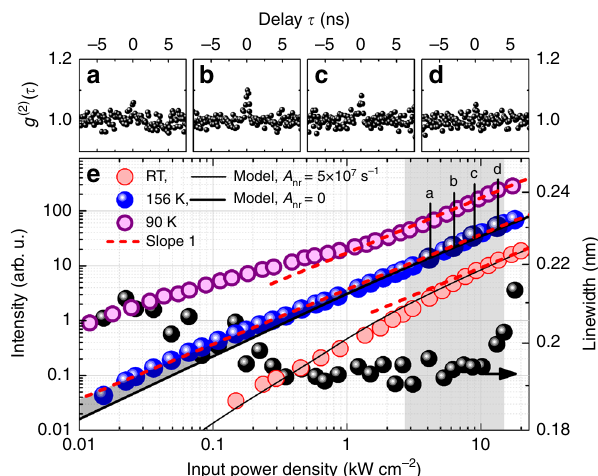
Fig. 3 Optical and quantum-optical characterization of the thresholdless nanobeam emission at a temperature of 156 K. a – d Autocorrelation traces taken at the excitation power densities marked in e display the characteristic bunching around threshold ( b , c ), which vanishes again for higher excitation ( d ), indicating a transition towards Poissonian emission statistics in the lasing regime (shaded excitation range in e ). The bunching in a cannot be fully resolved due to resolution limitation. e Excitation power-dependent I – O curve measured at 156 K (blue) exhibiting a thresholdless behavior and corresponding emission linewidth (black dots). I – O curves measured at room temperature (red) and 90 K (purple) show the development of the I – O characteristics with temperature. Results of our microscopic model, based on a purely 2D QW gain, are shown for RT and 156 K data (solid lines). The I – O curve at 156 K is shown under the assumption of negligible non-radiative losses (nonlinearity solely due to β < 1). The increased output intensity in the low excitation regime, due to contributions from localized states, is apparent at 156 K (shaded). Second- order autocorrelation measurements were performed at 156 K at the data points marked a – d. A slope of 1 is indicated by the red dashed lines. The vertical offset was adjusted for